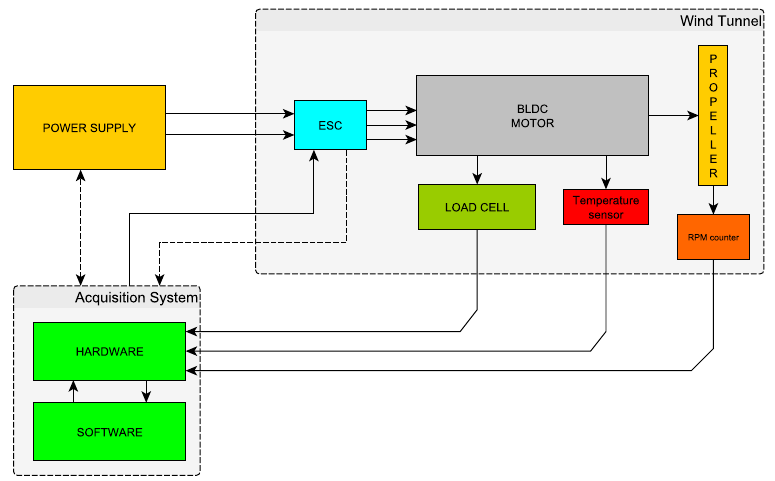
Figure 9. Motor control and data acquisition